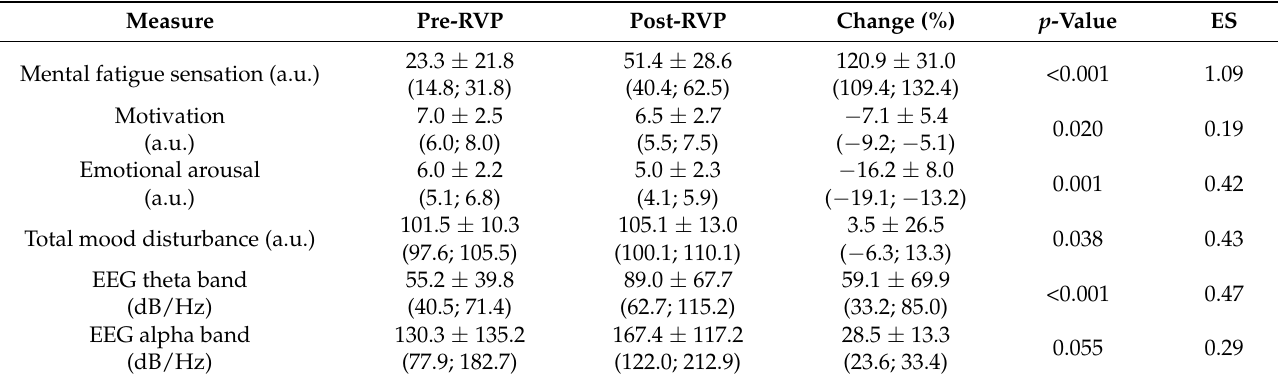
Table 1. Psychological and physiological variables frequently used to assess mental fatigue.